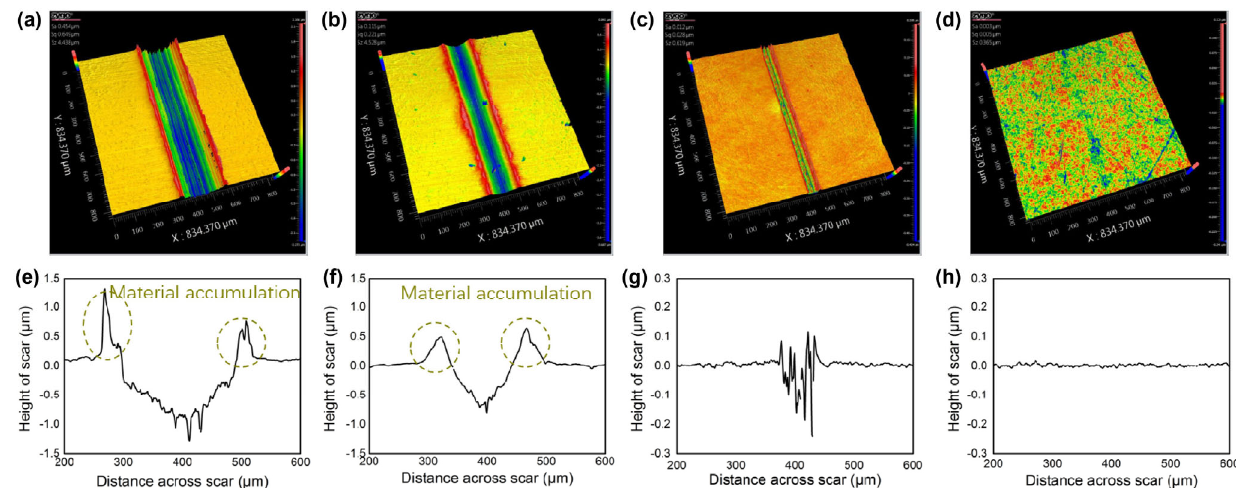
Fig. 7 (a)–(d) Three-dimensional white light interference images of the wear scars and (e)–(f) height of wear scars after friction tests at 3 N. Here, panels (a) and (e) are the copper disk lubricated with the base oil. Panels (b) and (f) are copper disks lubricated by TRGO lubricant, panels (c) and (g) are the steel disk lubricated by the base oil, and (d) and (h) for steel disks lubricated with TRGO